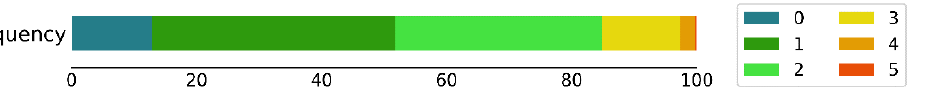
Figure 11. Number of grassland pixels with detected mowing frequency for Germany in percentage.